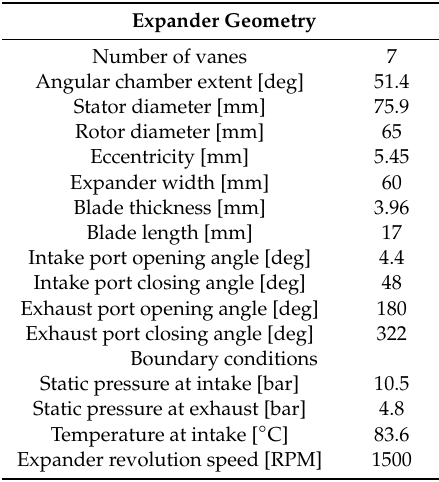
Table 1. Expander geometry and input